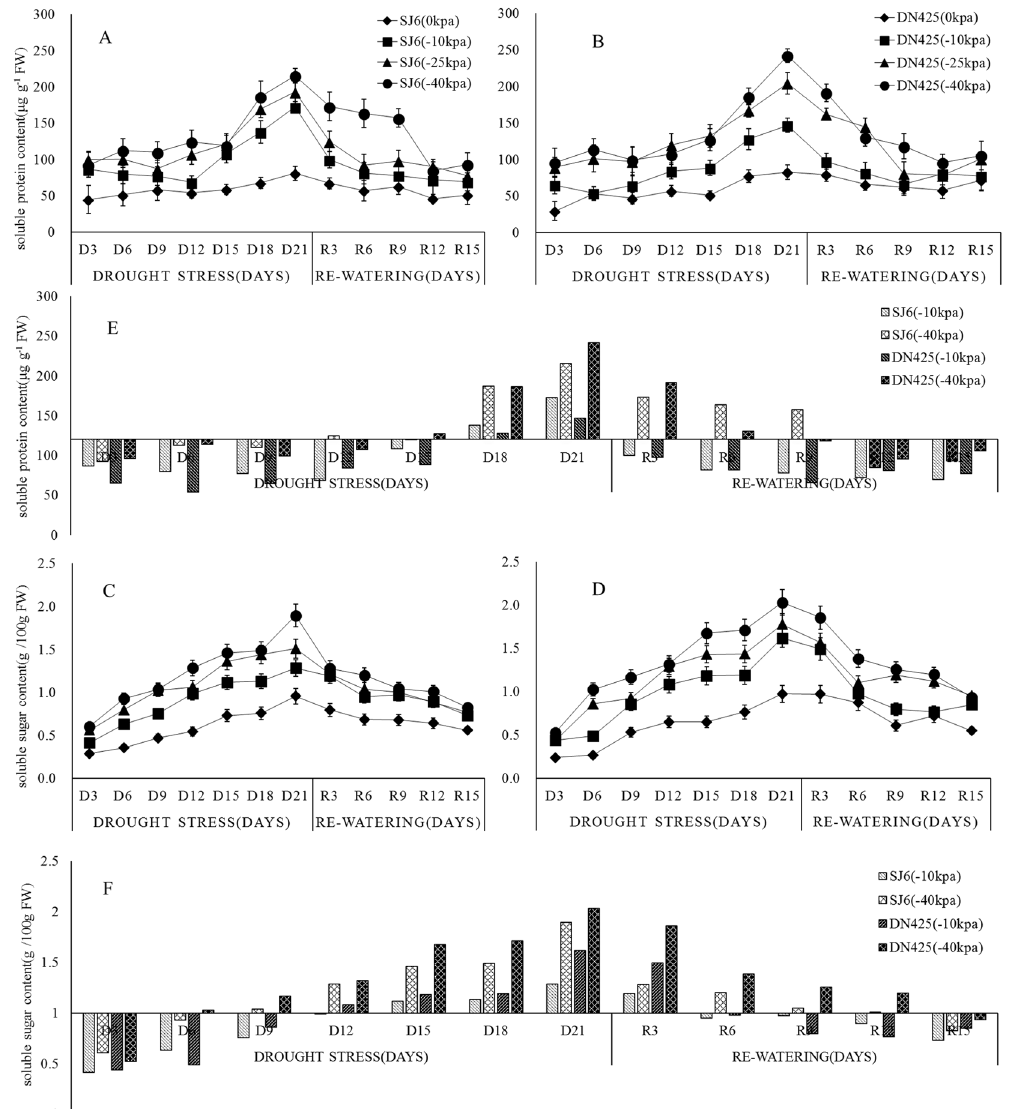
Figure 4. Effects of drought stress and re-watering on Soluble protein ( A , B ) and Soluble sugar ( C , D ) content in leaves at tillering stage of two rice cultivars in all treatments. The Soluble protein ( E ) and Soluble sugar ( F ) content in − 10 kPa and − 40 kPa treatment of SJ6 and DN425. SJ6, Songjing 6 (drought-sensitive); DN425, Dongnong 425 (drought-tolerant). The values represent the means ± SD (n = 3). The experiment was conducted at Northeast Agricultural University farm, Harbin, Heilongjiang Province, northeast